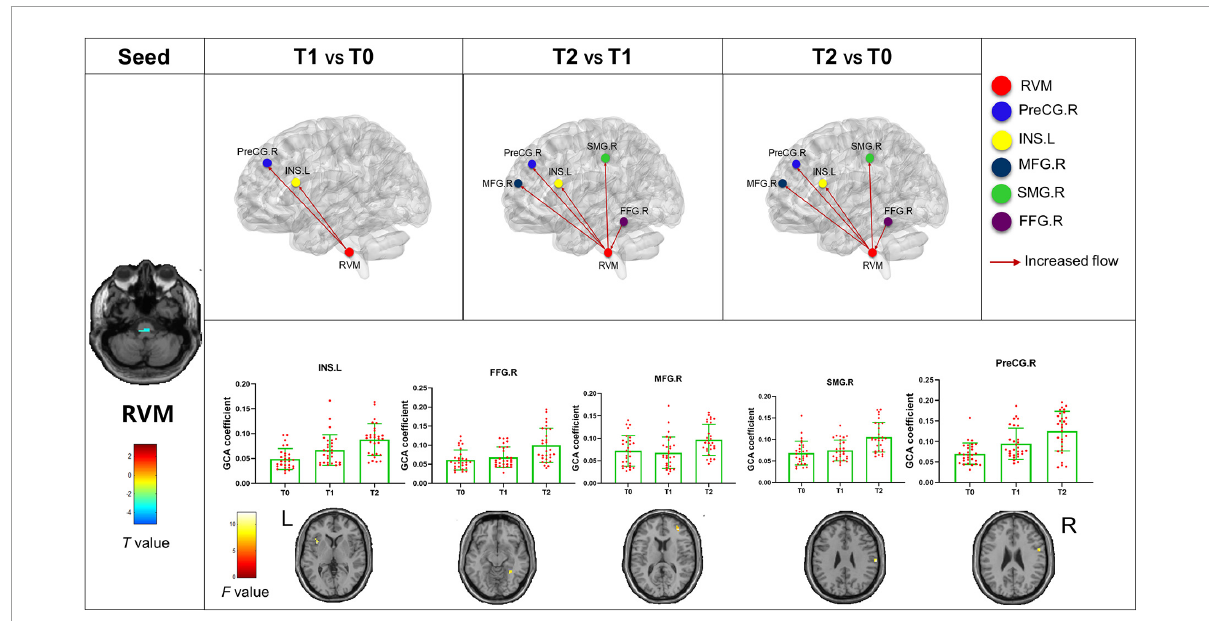
FIGURE4 Abnormal effective connectivity pathways associated with the RVM. Each bar chart reflects the values of the dynamic GCA coefficient in the corresponding group. Fuchsia arrows indicate significantly enhanced DEC variability. T0, the time point at baseline; T1, the time point after the first acupuncture session; T2, the time point after the 12th acupuncture sessions. All abbreviations are defined in the Abbreviations